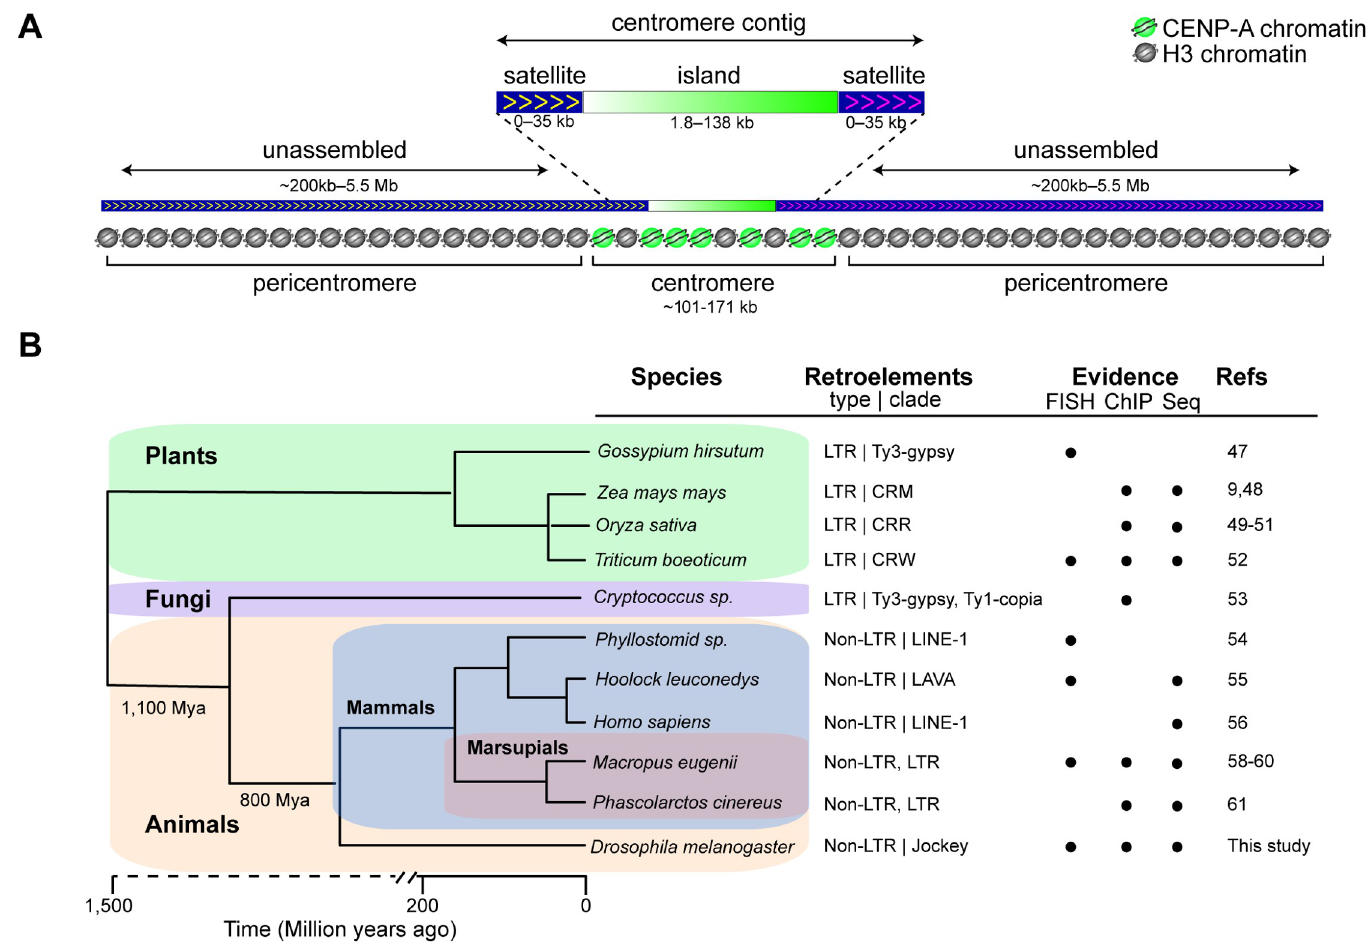
Fig 7. Drosophila centromere organization and widespread presence of retroelements at centromeres. (A) Schematic showing the organization of D . melanogaster centromeres. For at least CenX, Cen4, and Cen3, the bulk of CENP-A chromatin is associated with the centromere islands, whereas the remaining CENP-A is on the flanking satellites. The sequences flanking the Y centromere are not in our assembly, so whether CENP-A is also on satellites is unknown. Although the complexity of island DNA allowed us to identify centromere contigs by long-read sequencing, the flanking satellites remain largely missing from our genome assembly because of their highly repetitive nature. The approximate satellite size estimates are based on Jagannathan and colleagues’ work [25]. (B) Phylogenetic tree showing that centromere- associated retroelements are common across highly diverged lineages: Gossypium hirsutum (cotton) [47], Zea mays mays (maize) [9, 48], Oryza sativa (rice) [49–51], Triticum boeoticum (wild wheat) [52], Cryptococcus [53], Phyllostomid (bat) [54], Hoolock leuconedys (gibbon) [55], Homo sapiens (human) [56] (and a human neocentromere [57]), Macropus eugenii (tammar wallaby) [58–60], Phascolarctos cinereus (koala) [61], and D . melanogaster (this study for endogenous centromeres; also in an X-derived minichromosome [14, 15]). The phylogeny was constructed using TimeTree [62]. Indicated are the retroelement type and the clade that the element belongs to with element types as follows: LTR and non-LTR. The circles indicate the experimental evidence for centromere association of retroelements: FISH, CENP-A ChIP-seq (ChIP), and genome or BAC sequencing (Seq). BAC, bacterial artificial chromosome; CENP-A, centromere protein A; CenX, X centromere; ChIP-seq, chromatin immunoprecipitation sequencing; CRM, centromeric retrotransposons of maize; CRR, centromeric retrotransposons of rice; CRW, centromeric retrotransposons of wheat; FISH, fluorescence in situ hybridization; LAVA, LINE-Alu-VNTR-Alu-like; LINE, long interspersed nuclear element; LTR, long terminal repeat; Mya, million years ago.